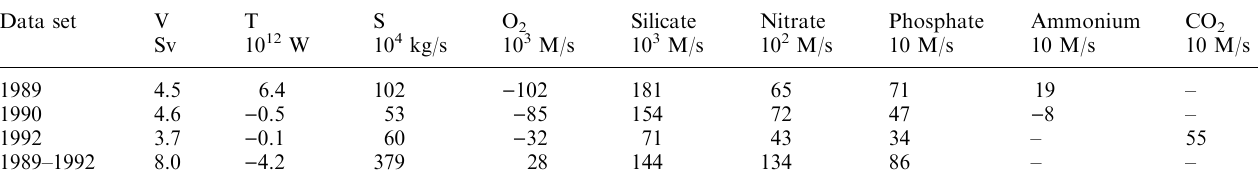
Table 6. Tracer transports by standard dynamical analysis Data set V S O